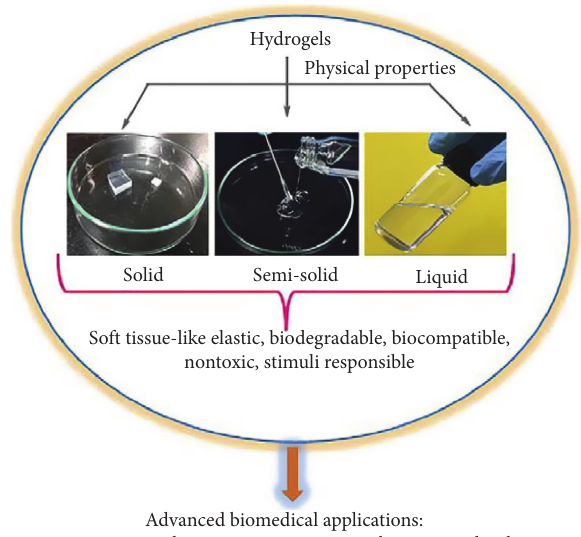
Figure 1: Physical nature of hydrogels (adapted from